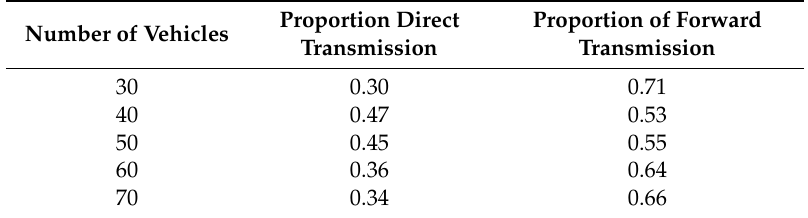
Table 9. Proportion of Direct and Forward